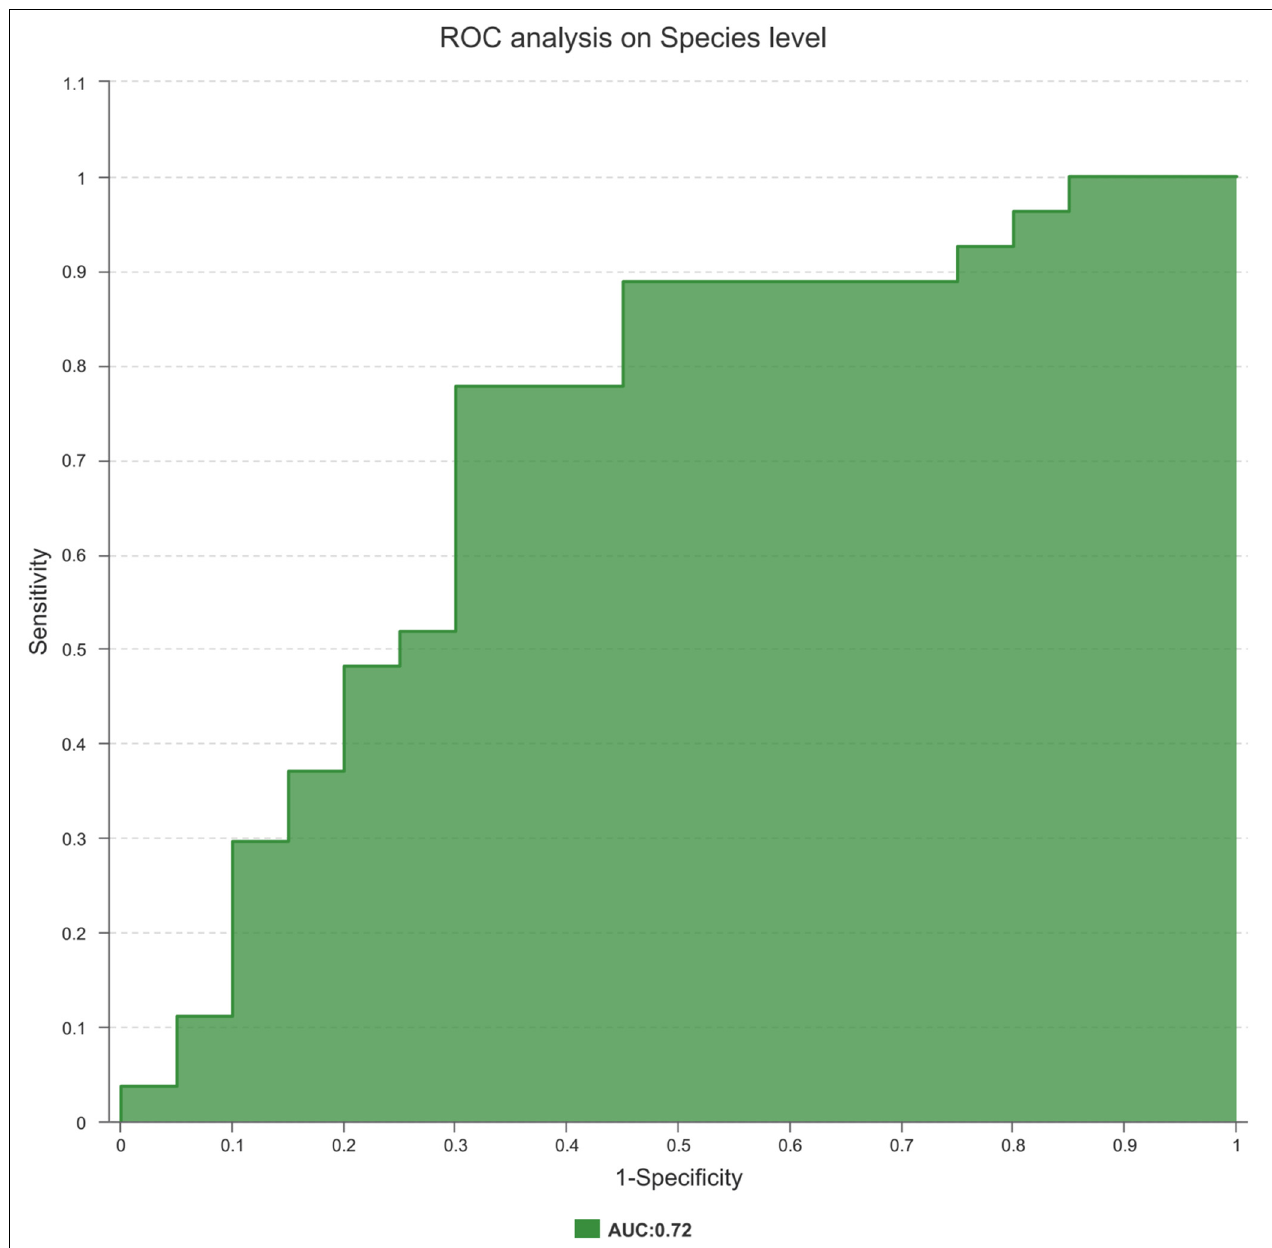
FIGURE 6 | The ROC curve used to analyze the clinical accuracy of using differential bacteria obtained from the CA group and NCA group for the diagnosis of